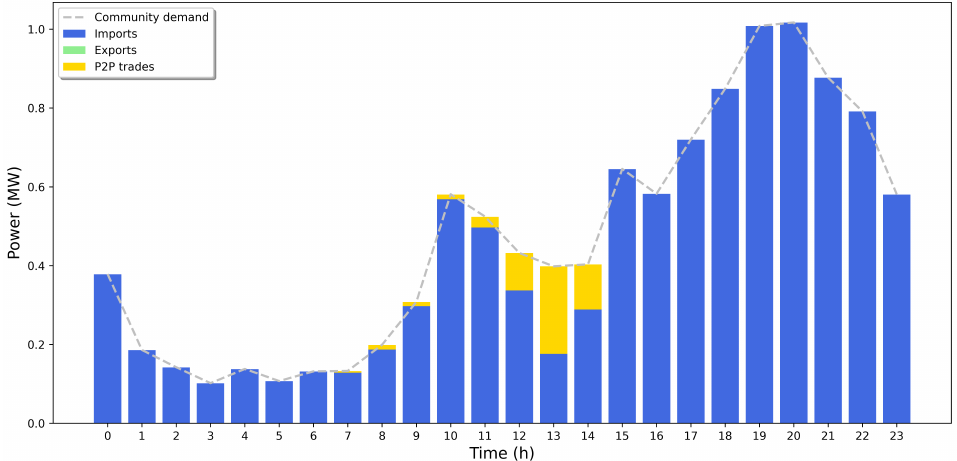
Figure 8. P2P internal trades, imports, and exports for the simulated period.